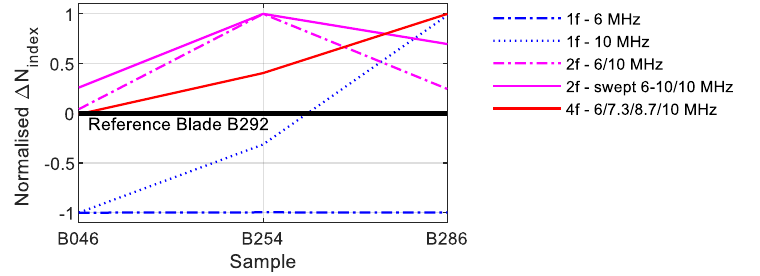
Figure 35. Nonlinearity parameter — δ G4 .